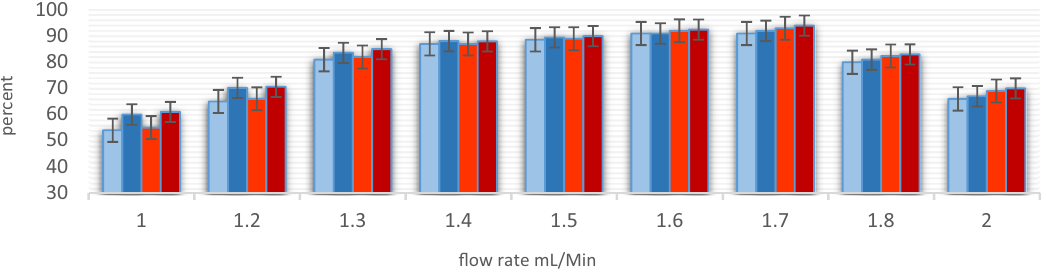
Figure 7. The bar chart for particles separation results at various flow